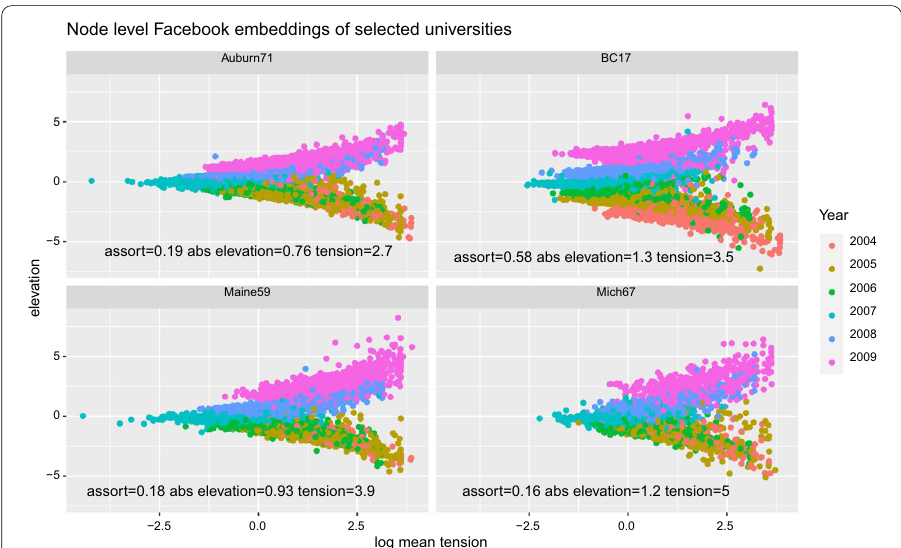
Fig. 7 The node level embedding shows that the tension and elevation distribution of nodes by type are distinct and related to the overall network tension and elevation; this is not possible to explore with